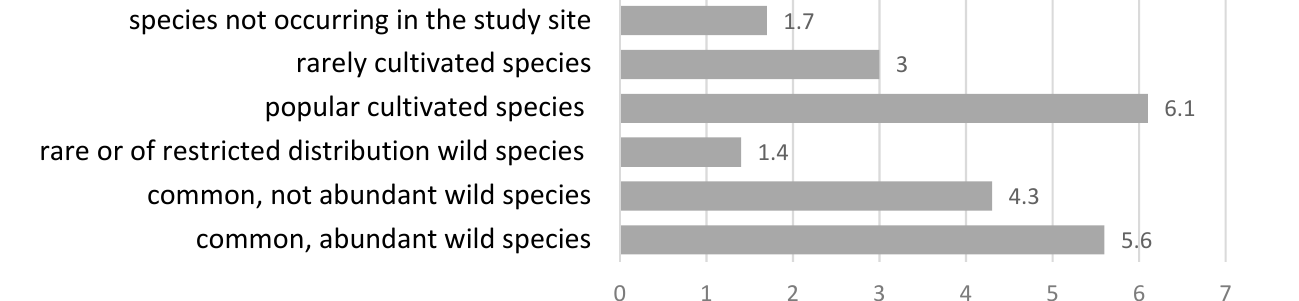
Figure 1. Mean use report of number per species in plant species frequency categories.